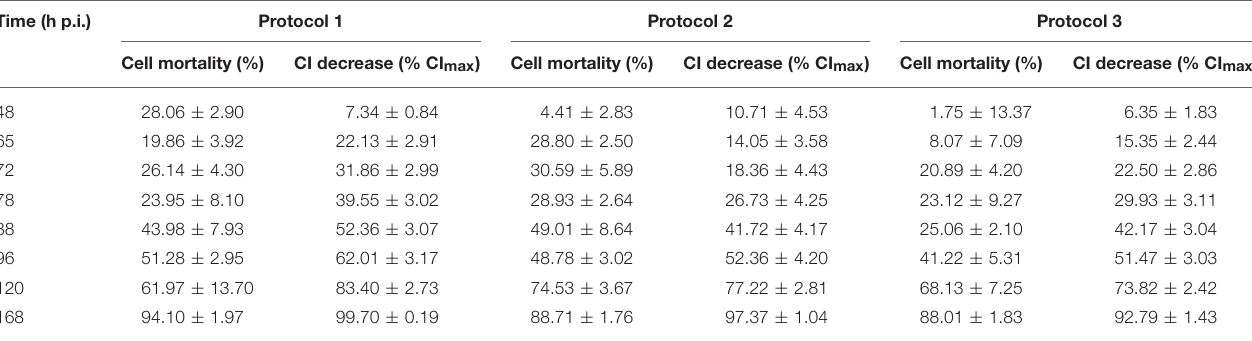
TABLE 3 | Correlation between RTCA assay and cell viability assay. Time (h